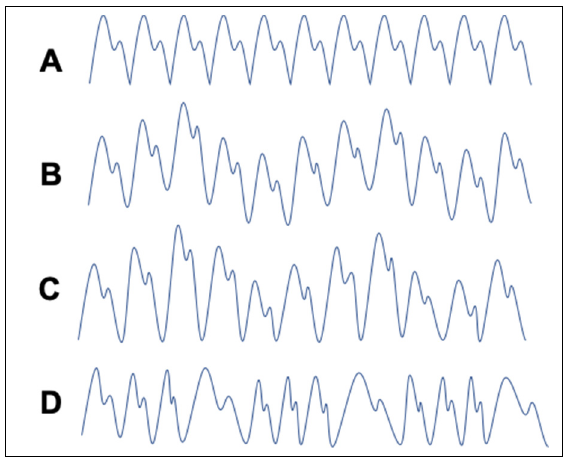
Figure 1. Illustrative examples of the photoplethysmographic signal showing: ( A ) no modulation or wander; ( B ) baseline wander; ( C ) amplitude modulation; ( D ) pulse width modulation potentially induced by breathing cycles.